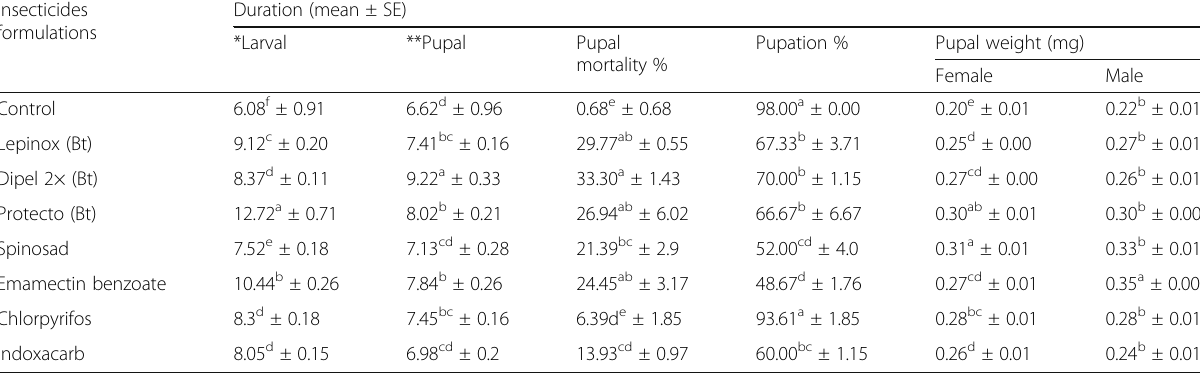
Table 3 Effects of the sub-lethal concentration, LC 30 value, of tested bio-and chemical insecticides on the development parameters of Tuta absoluta from 2nd instar larvae to eclosion Insecticides